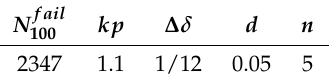
Table 2. Battery cost parameters.